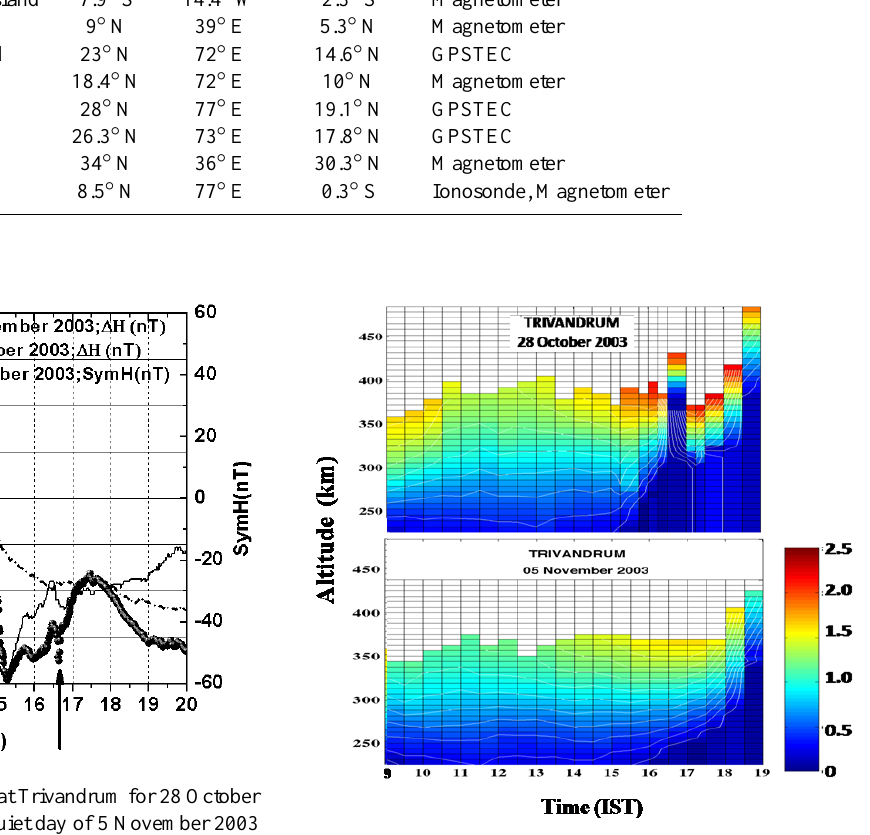
Fig. 2. The time variations of real height and electron density at Trivandrum for 28 October 2003 (top panel) and the sample quiet day (bottom